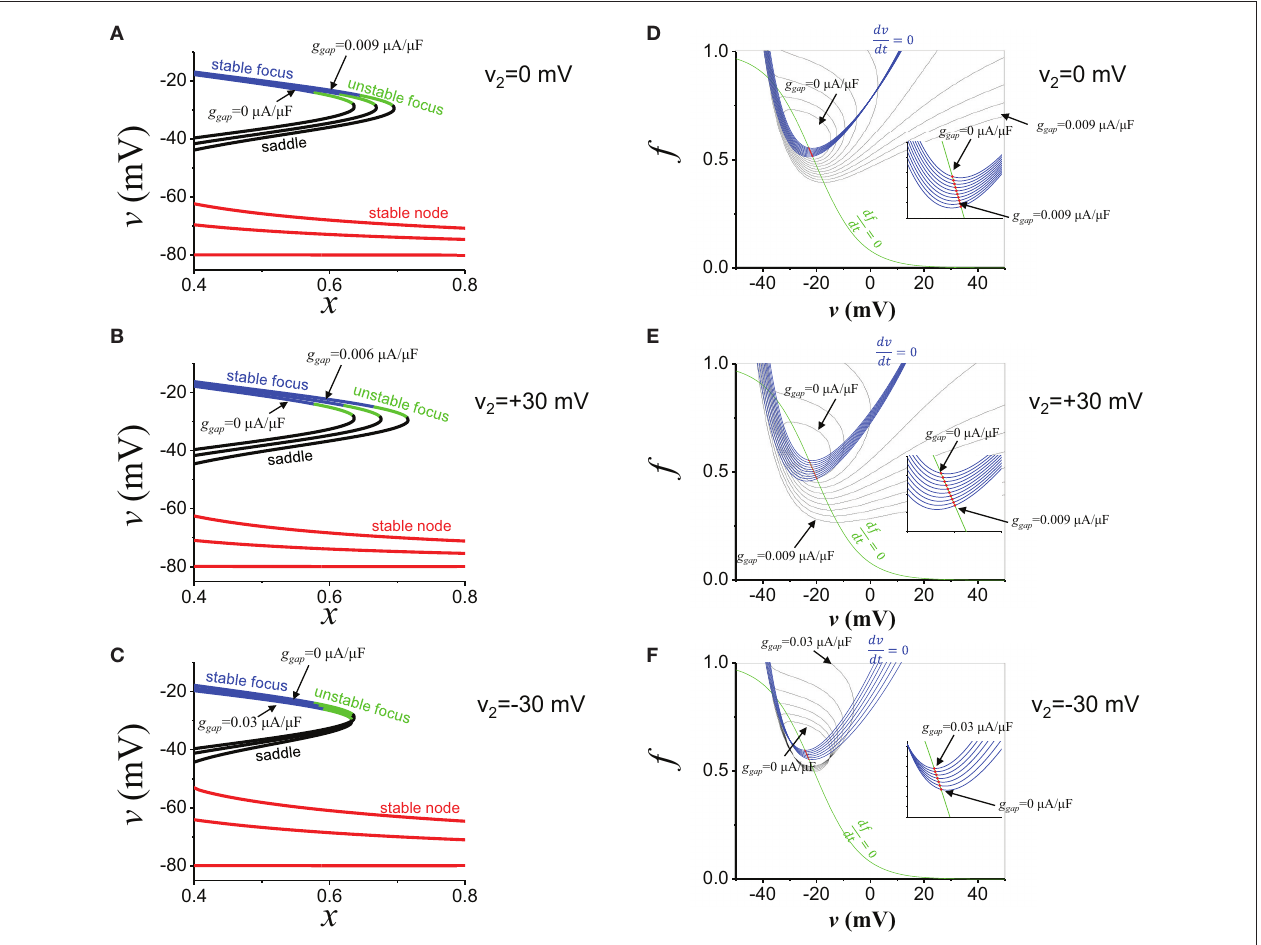
FIGURE 7 | EAD mechanisms. (A) The stability of the fats subsystem ( v,f ). x is the parameter. Blue: stable focus. Green: unstable focus. Black: saddle. Red: stable node. g gap values are 0, 0.0045, and 0.009 µ A/ µ F. v 2 is 0mV. (B) The same as (A) , but v 2 is (A) , but v 2 is 30mV. g gap values are 0, 0.015, and 0.03 µ A/ µ F. (D) Basin of attraction. g gap value was varied from 0 to 0.009 µ A/ µ F. v 2 is 0mV. Red dots indicate − fixed points. Blue and green lines are nuclines. (E) The same as (D), but v 2 is 30mV. g gap value was varied from 0 to 0.03 µ A/ µ −